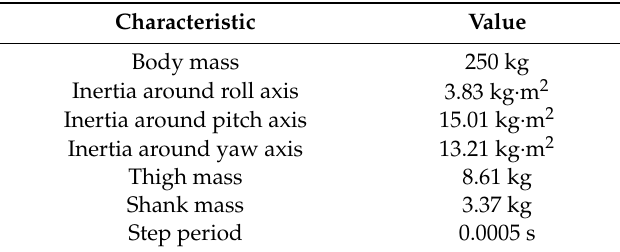
Table 7. The simulation parameters of robot in ADAMS.